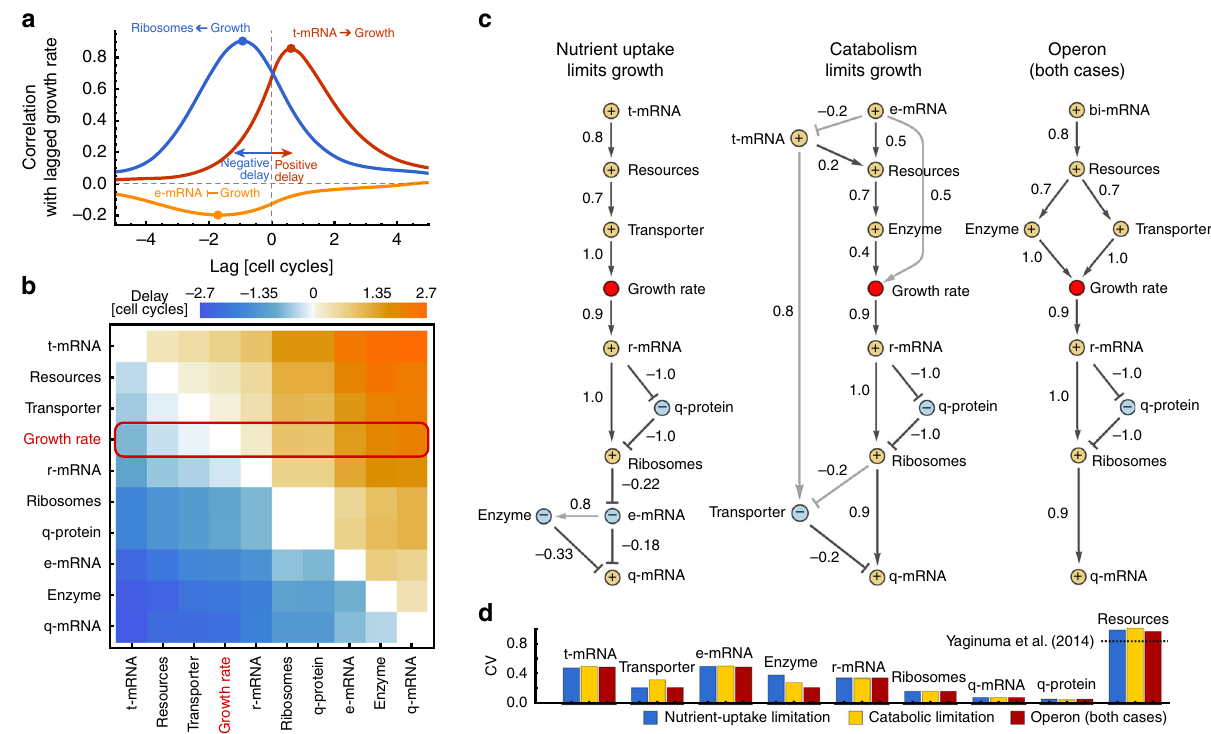
Fig. 4 Cross-correlation analysis reveals the propagation of fl uctuations. a Concentrations of transporter mRNA (t-mRNA) correlate positively with growth rate at later times (red line, maximum correlation at positive lag) indicating that they increase growth rate. Ribosome concentrations correlate positively with growth at earlier times (blue line, maximum correlation at negative lag) indicating that they are increased by growth rate. Concentrations of enzymatic mRNA (e-mRNA) correlate negatively, indicating that they are mainly diluted by growth (yellow line, minimum correlation at negative lag). b Pairwise delays between cellular components and growth rate (red box), ordered by their delay with respect to growth rate, computed in moderate growth conditions (1.4 dbl/hr). c Minimal delay graphs illustrate the information fl ow under growth limitations with comparable growth rates. A dark arrow from species A to B indicates that B has minimal delay from A, suggesting that species B is the fi rst to receive fl uctuations from species A. Arrows denote positive correlations at the delay, T-arrows negative correlations, and labels denote the delayed-correlation coef fi cient. Light arrows indicate components with second smallest delay whenever these are not reached through subsequent steps. The graph reveals cellular components up- and downstream of growth rate, i.e. those that affect growth and those affected by growth. When nutrient-uptake is limiting growth, t-mRNA act as a source of fl uctuations, while for catabolic limitation e-mRNA are the dominant source (cf. Fig. 3). The corresponding proteins are upstream of growth and transmit fl uctuations to growth rate. When transporters and enzymes are co-expressed from an operon the different limitations are indistinguishable. In all cases, q-mRNAs act as a sink due to their negative autoregulation, q-proteins are mainly diluted (nodes labelled with − correlate negatively with growth) while most species increase with growth (nodes labelled with + correlate positively with growth). d Fluctuations (CV) in concentrations of the transcriptome, proteome and resources are comparable across the considered cases. The dashed line indicates measured fl uctuations in intracellular ATP